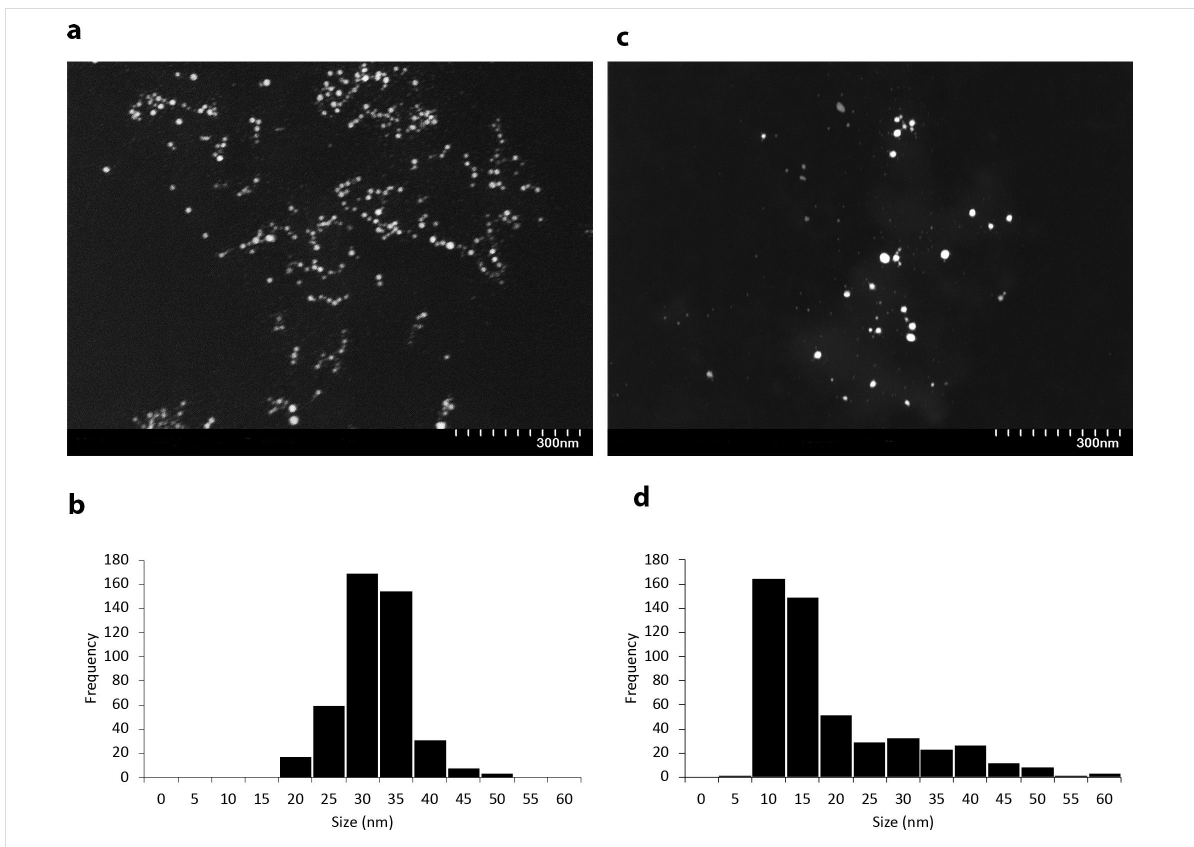
Figure 1: STEM images of 1000 µg·L − 1 PVP-AgNPs and particle size distribution obtained from ImageJ. PVP-AgNPs in RPMI medium (without cells) at (a, b) t = 0, size distribution = 29 ± 0.49 nm and at (c, d) t = 24 h, size distribution = 17 ± 11 nm, under the same conditions as during exposure to cells (incubator at 37 °C with 5% CO 2